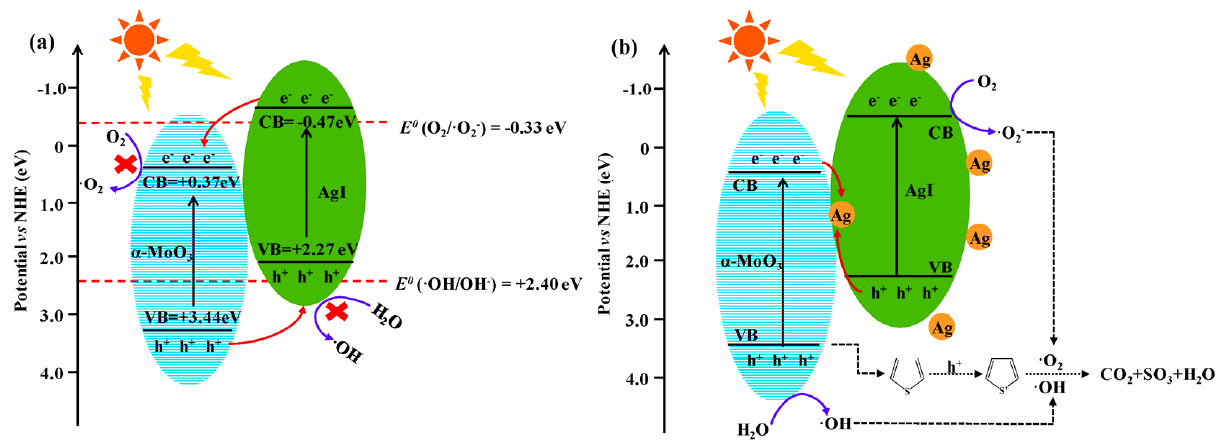
Figure 9. ( a ) Mechanism of PODS on the AgI/ α -MoO 3 type-II heterojunction photocatalyst. ( b ) Mechanism of PODS on the AgI/ α -MoO 3 ASS Z-scheme heterojunction photocatalyst. Reproduced from ref. [123] with permission from MDPI. Copyright 2019 MDPI.